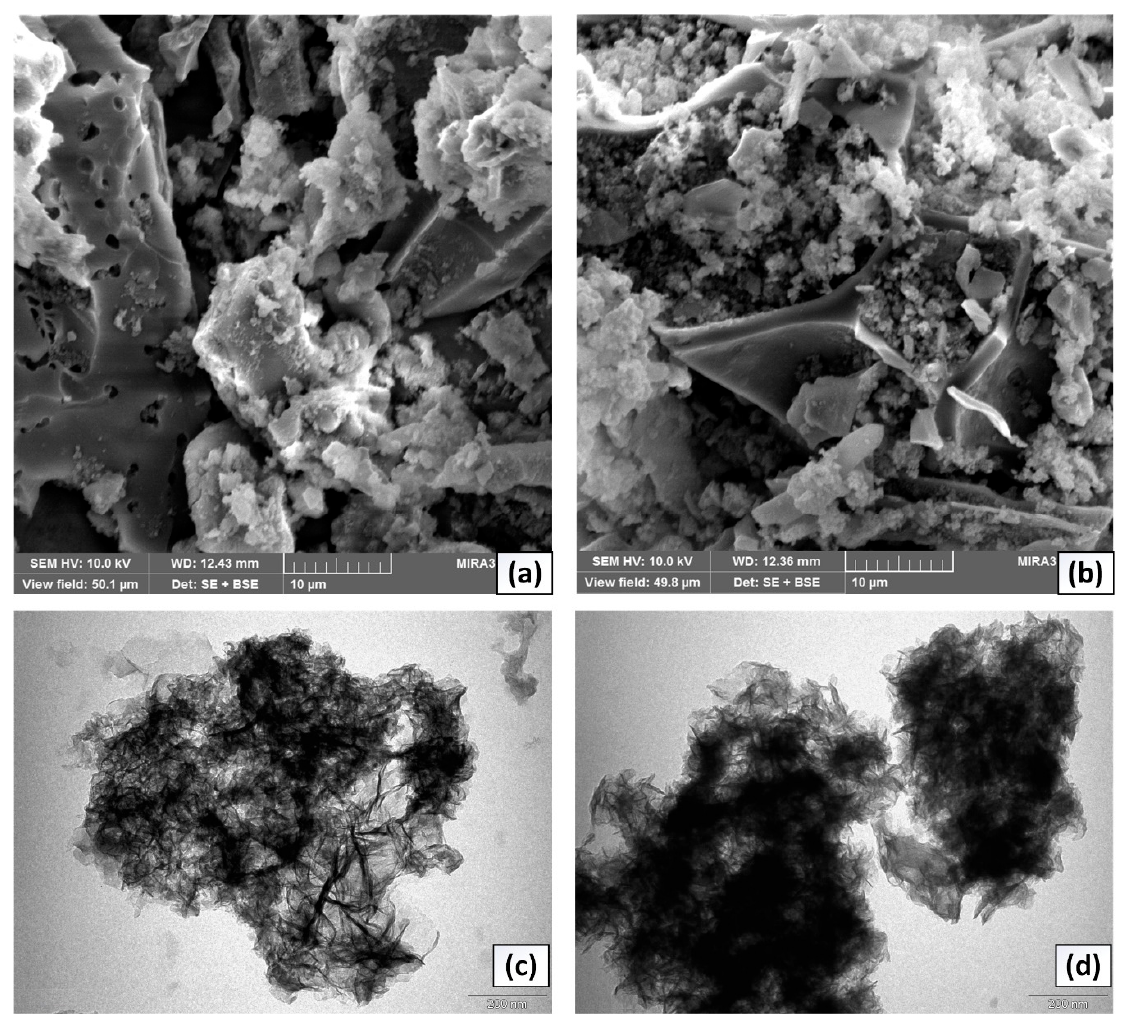
Figure 2. SEM images of (a): B 5 MgAl and (b) B 10 MgAl composites and TEM images of (c) B 5 MgAl and (d) B 10 MgAl composites.